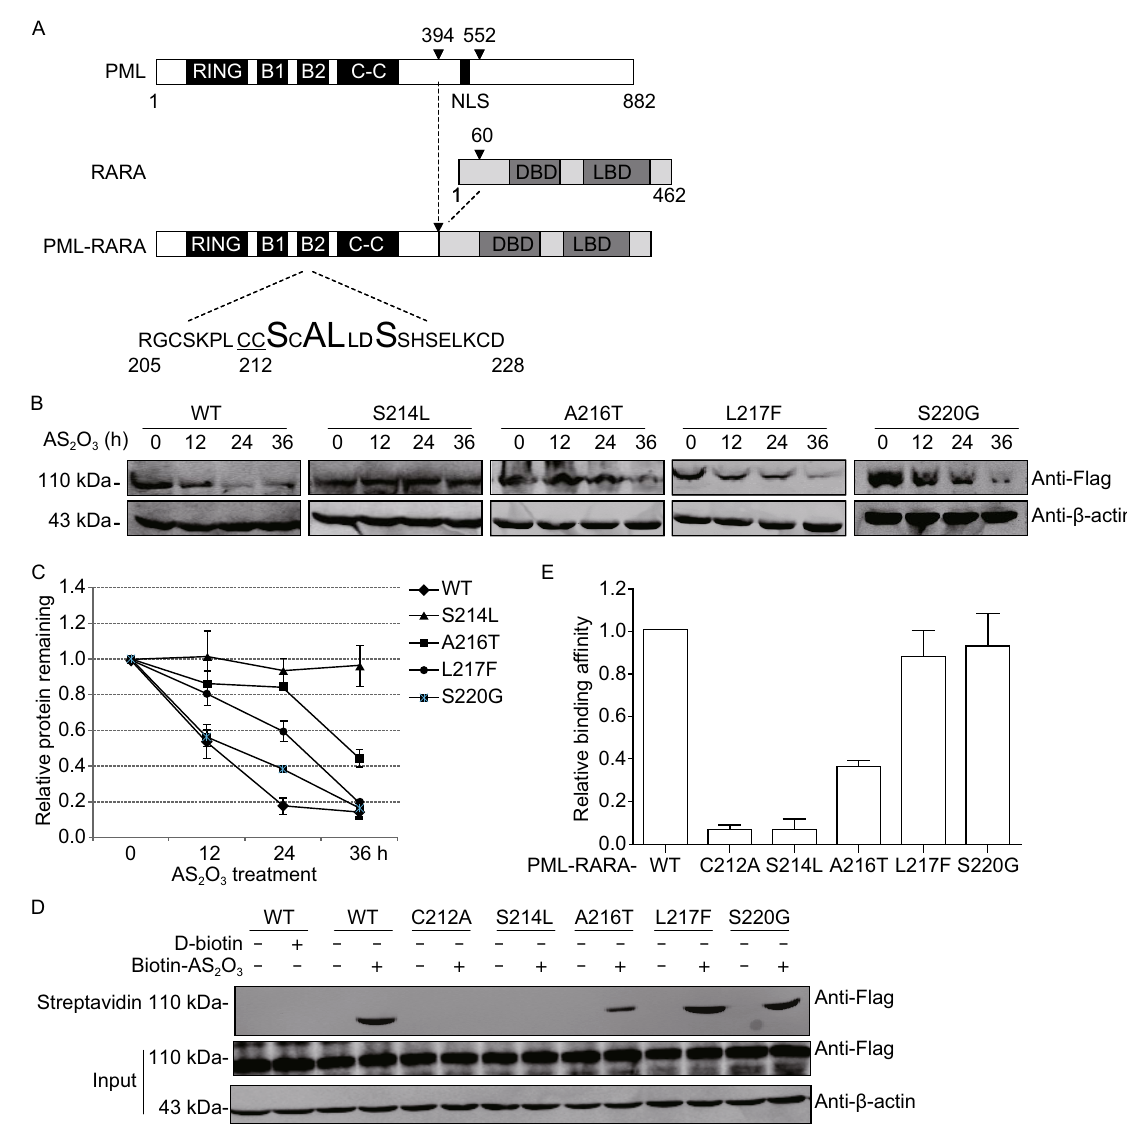
Figure 1. The effects of AS 2 O 3 on the degradation of PML-RARA mutants . (A) Schematic model of PML, RARA, and the fusion protein. The functional domains of PML and RARA are indicated with black and gray, respectively. RING refers to the RING fi nger; B1 and B2, B-box motifs; C-C, coiled-coil; and DBD, DNA-binding domain. Black arrows indicate the break points of the fusion proteins PML-RARA. The CC motif (C212/213) required for AS 2 O 3 binding is underlined. The mutation sites Ser214, Ala216, Leu217 and Ser220 were highlighted in bold. (B) NB4 cells transfected with different plasmids were treated with 2 µmol/L AS 2 O 3 for the indicated time and AS 2 O 3 -induced PML-RARA degradation was evaluated by Western blot using anti-Flag antibody. (C) Quanti fi cation of the relative protein level of PML-RARA mutants with AS 2 O 3 treatment showed in Fig. 1B was calculated. The protein abundance of PML- RARA without AS 2 O 3 treatment (0 h) was presented as ‘ 1 ’ and the level of PML-RARA with AS 2 O 3 treatment for the indicated time was expressed relatively to this. The error bars represent standard error. (D) CHO cells transfected with indicated PML-RARA mutants were treated with 10 µmol/L AS 2 O 3 for 2 h. Cells were harvested and lysed in 8 mol/L urea buffer. The supernatant was incubated with streptavidin agarose beads overnight at 4°C. After extensive wash, the streptavidin beads were resuspended in 30 µL SDS-PAGE loading buffer. The binding of arsenic with PML-RARA was analyzed by Western blot. (E) The binding af fi nity of PML- RARA mutants with arsenic observed in Fig. 1D was quanti fi ed. The ratio was described relatively to the binding af fi nity of wild-type PML-RARA with